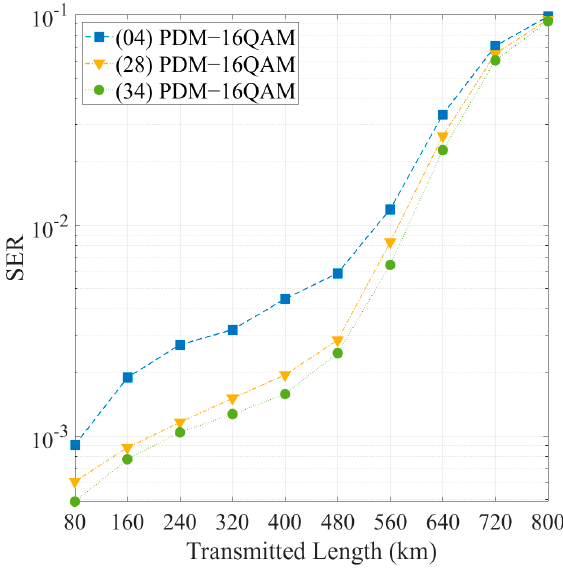
Figure 9. SER vs. Transmitted Length for PDM-16 QAM signal (OSNR = 20.2 dB).